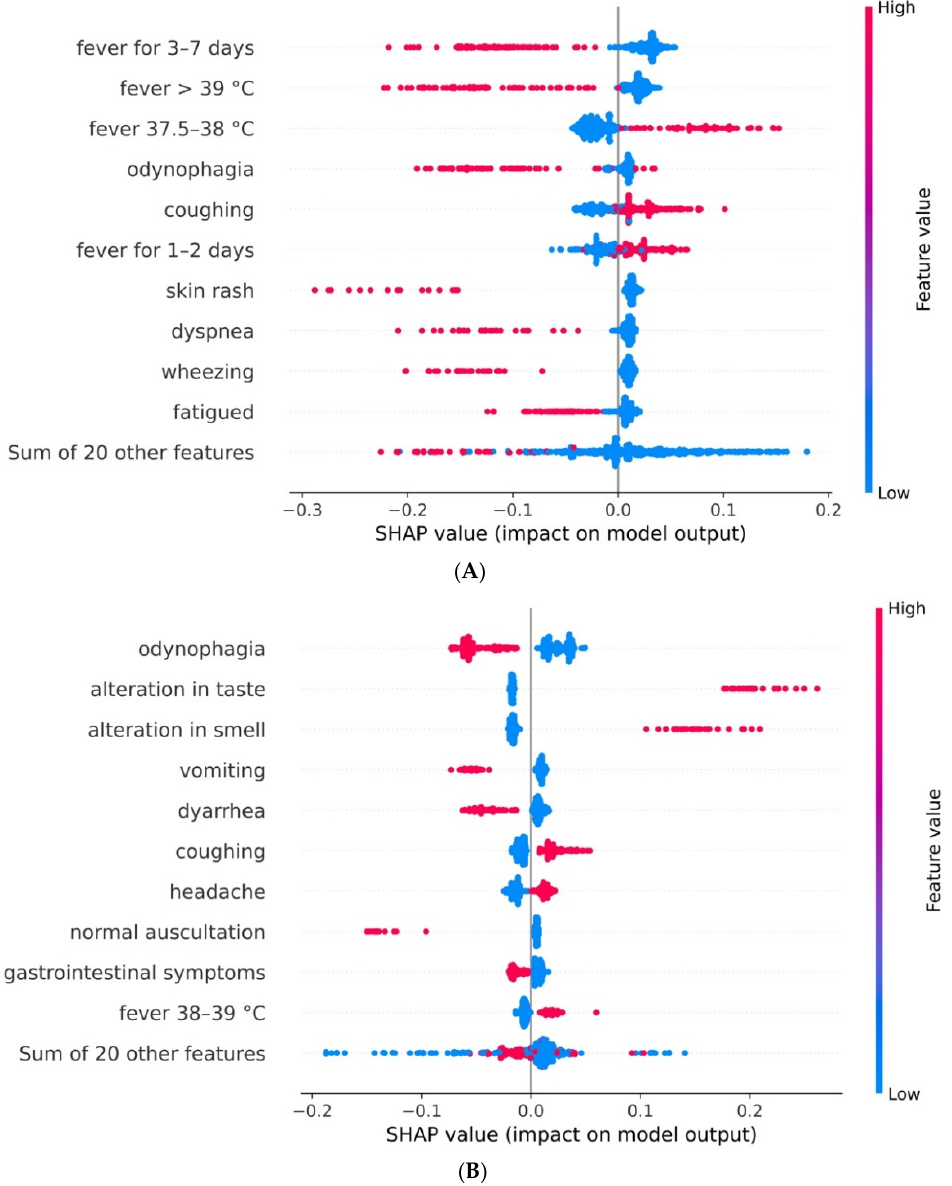
Figure 4. ( A ) Impact of each variable on the model output for the model for children 0 to 5 years old and ( B ) for children 6 to 15 years old. The features are organised top-down, by decreasing overall importance. For each feature, the SHAP value of each test observation is shown as a point. Each symptom is present if the colour of the point is red and absent if it is blue. The more to the right the points are, the more the output is associated with a SARS-CoV-2